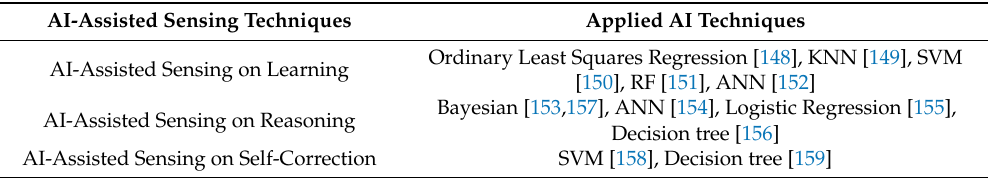
Table 6. The applied AI techniques in optical sensing on learning, reasoning, and